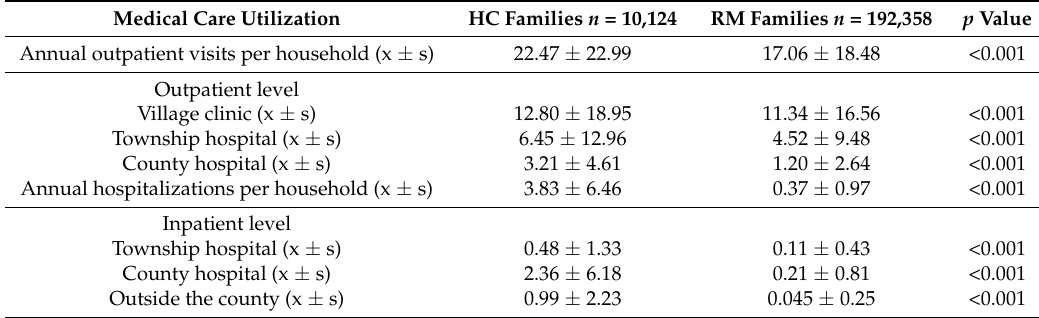
Table 3. Medical care utilization of different family groups in Macheng in